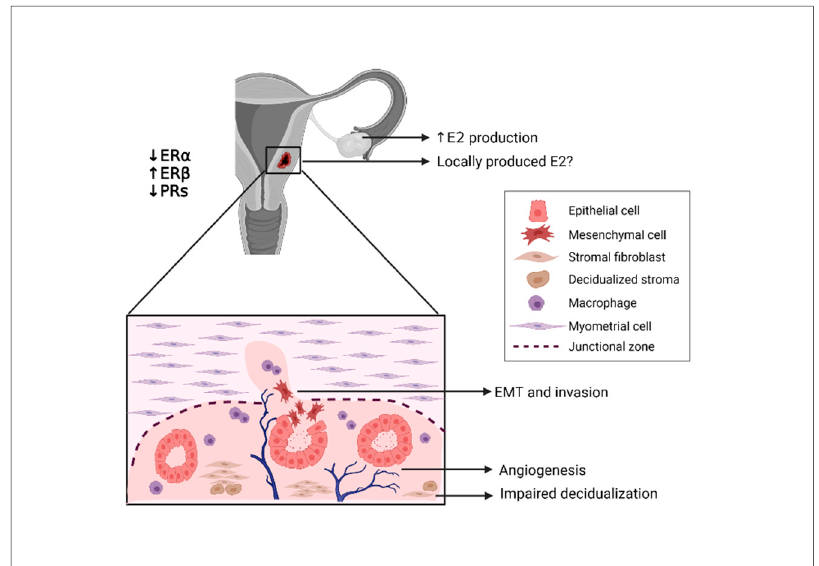
Figure 2. Effects of estrogen during adenomyosis development. Increased ovary-secreted estrogen, potentially combined with that of endometrial origin, triggers an inflammatory response in the endometrium, characterized by macrophage infiltration, angiogenesis, and EMT with subsequent invasion of the myometrium by endometrial cells. At the same time, dominance of ER β over ER α downregulates PR-B expression, resulting in progesterone resistance and inability of the endometrium to transform into a secretory decidualized state.